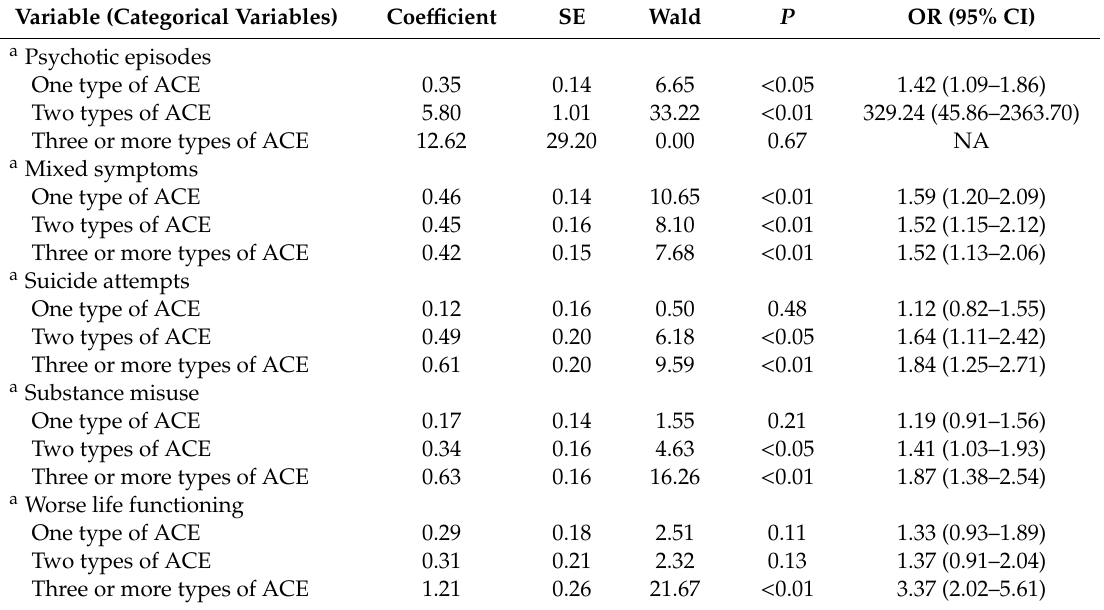
Table 5. Individual odds ratios for the number of adverse childhood experiences and the clinical outcomes of BD compared to the group with no adverse childhood experiences